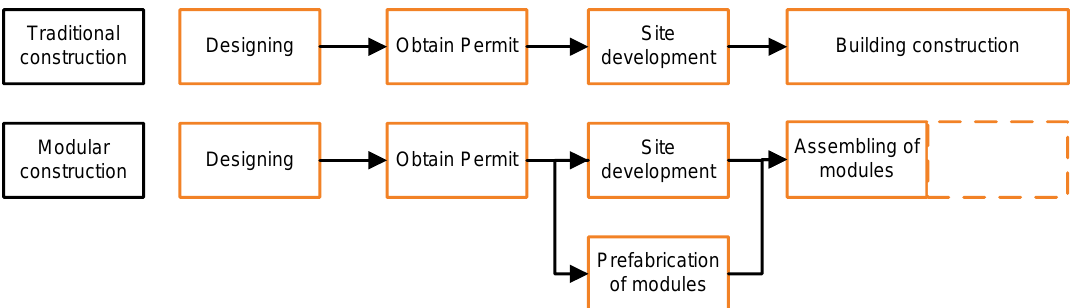
Figure 1. Phases involved in traditional and modular construction.